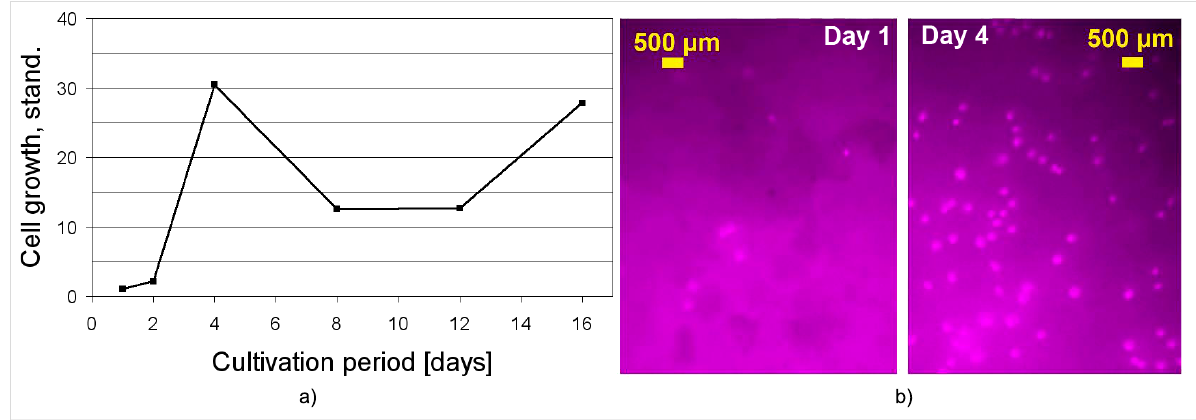
Figure 2: (a) Cell growth of human adipose tissue-derived stromal cells. Each data point is the average of 12 data points. (b) Fluorescence microscopy images of living cells after one and four days of cultivation; cells (human adipose tissue-derived stem cells) grown on a COE -based scaf- fold reinforced with 12 wt % CaCO 3